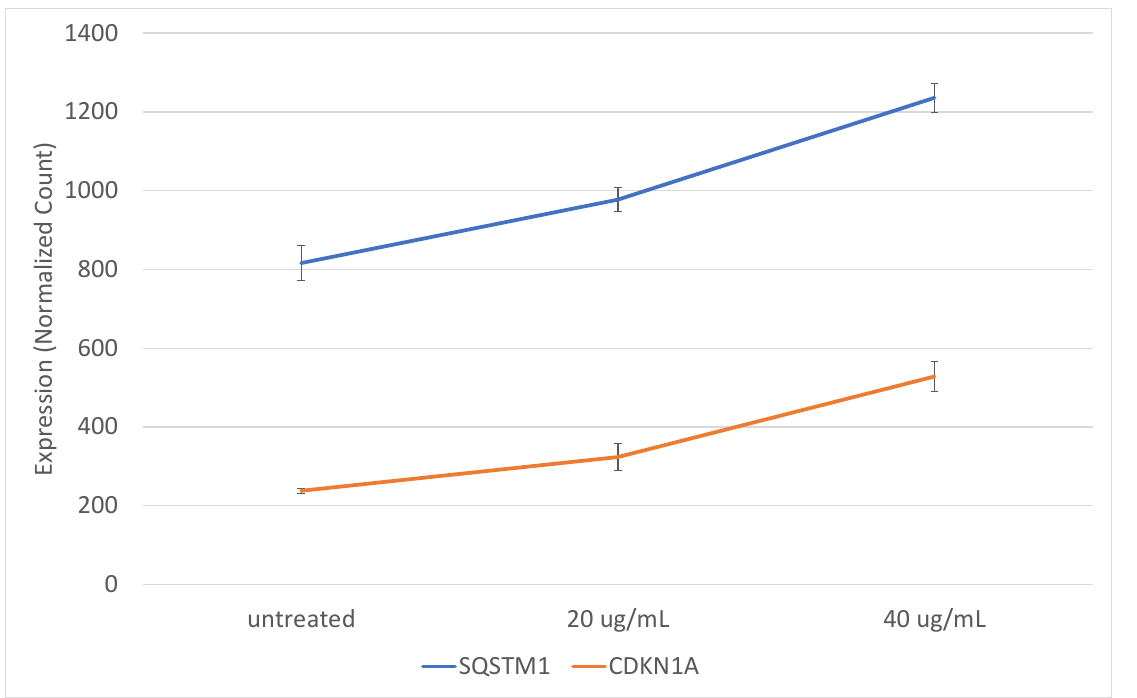
Figure 5. Key signaling nodes are induced by exosomes from epileptogenic tissue. SH-SY5Y cells were incubated with exosomes from epileptogenic tissue at 20 and 40 ug/mL. Gene expression was measured using Nanostring nCounter assays. SQSTM1 and CDKN1A are highly connected nodes in the network of induced genes and have a clear dose response. Error bars represent standard error of the mean.